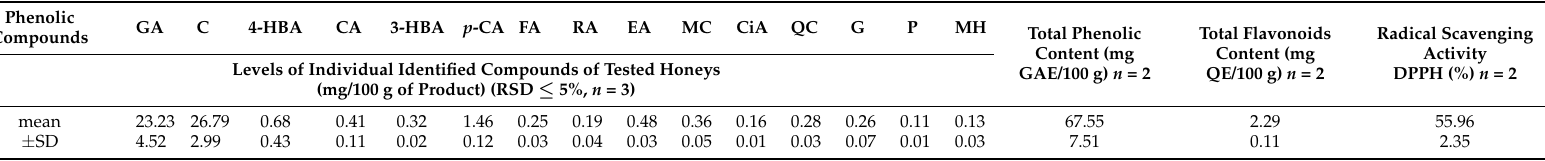
Table 4. The level of individual identified phenolic compounds (mg/100 g of product) and content of total phenolics (GAE—gallic acid equivalent) and flavonoids. (QE—quercetin equivalent) compounds in Polish yellow sweet clover honeys (methanolic